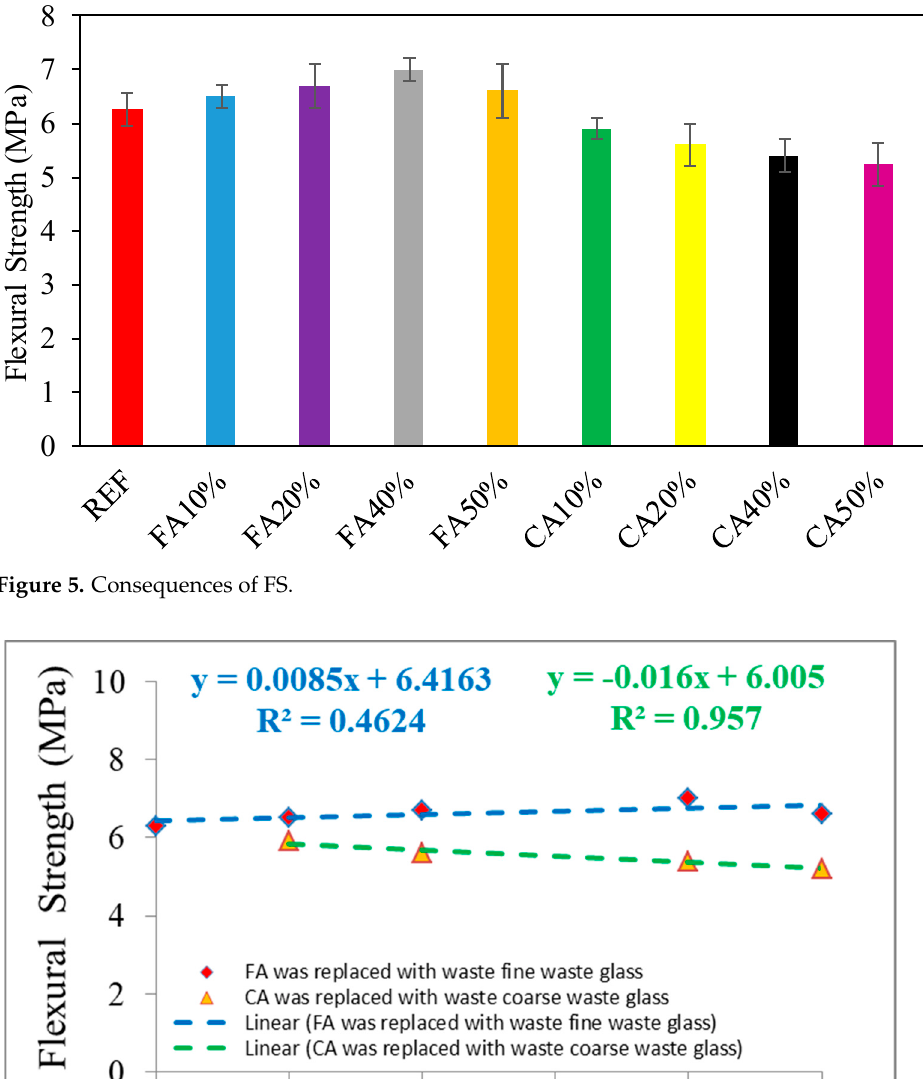
Figure 6. Consequences of tensile FS tests of concrete examples with changed CWG substances.